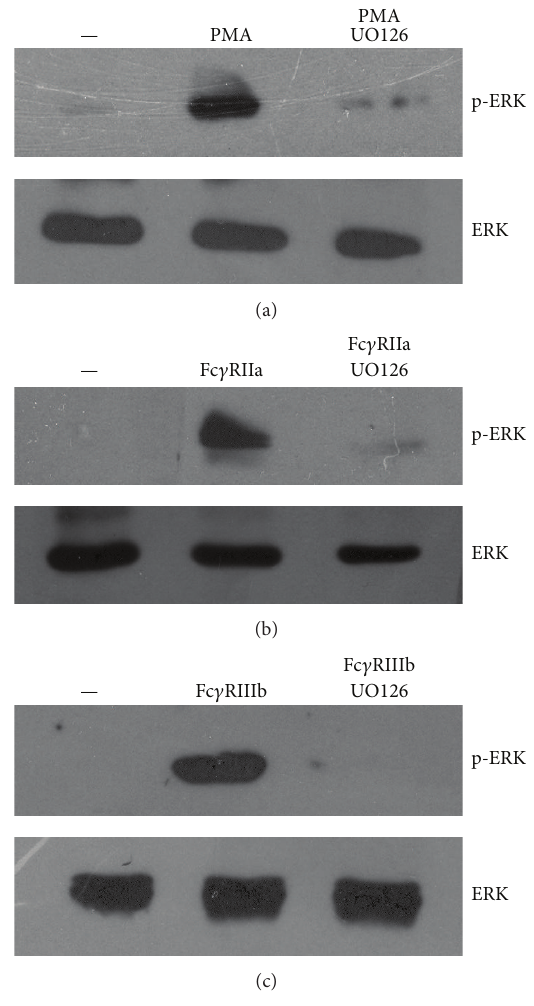
Figure 6: Fc 𝛾 R-cross-linking induces activation of ERK. Human neutrophils (PMN) were left untreated (—) or were stimulated (a) with 20 nM phorbol 12-myristate 13-acetate (PMA) or (b) by cross- linking Fc 𝛾 RIIa with mAb IV.3 or (c) by cross-linking Fc 𝛾 RIIIb with mAb 3G8. PMN were also stimulated in the presence of the MEKinhibitorUO126(50 𝜇 M).PMNcelllysateswerepreparedafter 30 min stimulation. Proteins were resolved by SDS-PAGE and then Western blotted for phosphorylated-ERK (p-ERK) (upper panel) or for total ERK (lower panel). Data are representative of three separate